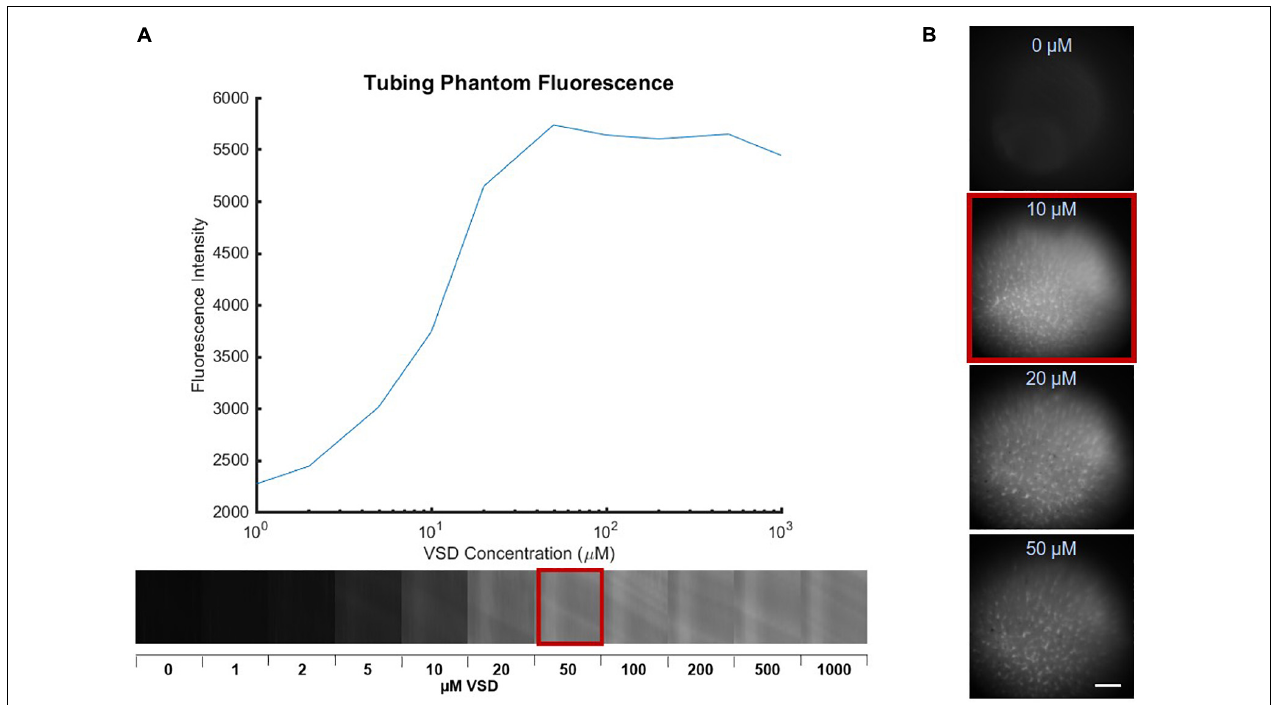
FIGURE 3 | Fluorescence images of various VSD concentrations in (A) tube phantoms with the plot showing peak fluorescence at 50 µ M, indicating the aggregation threshold in the absence biological cells and (B) PCN cultures with peak fluorescence at 10 µ M, which further reduced the aggregation threshold. Scale bar = 650 µ